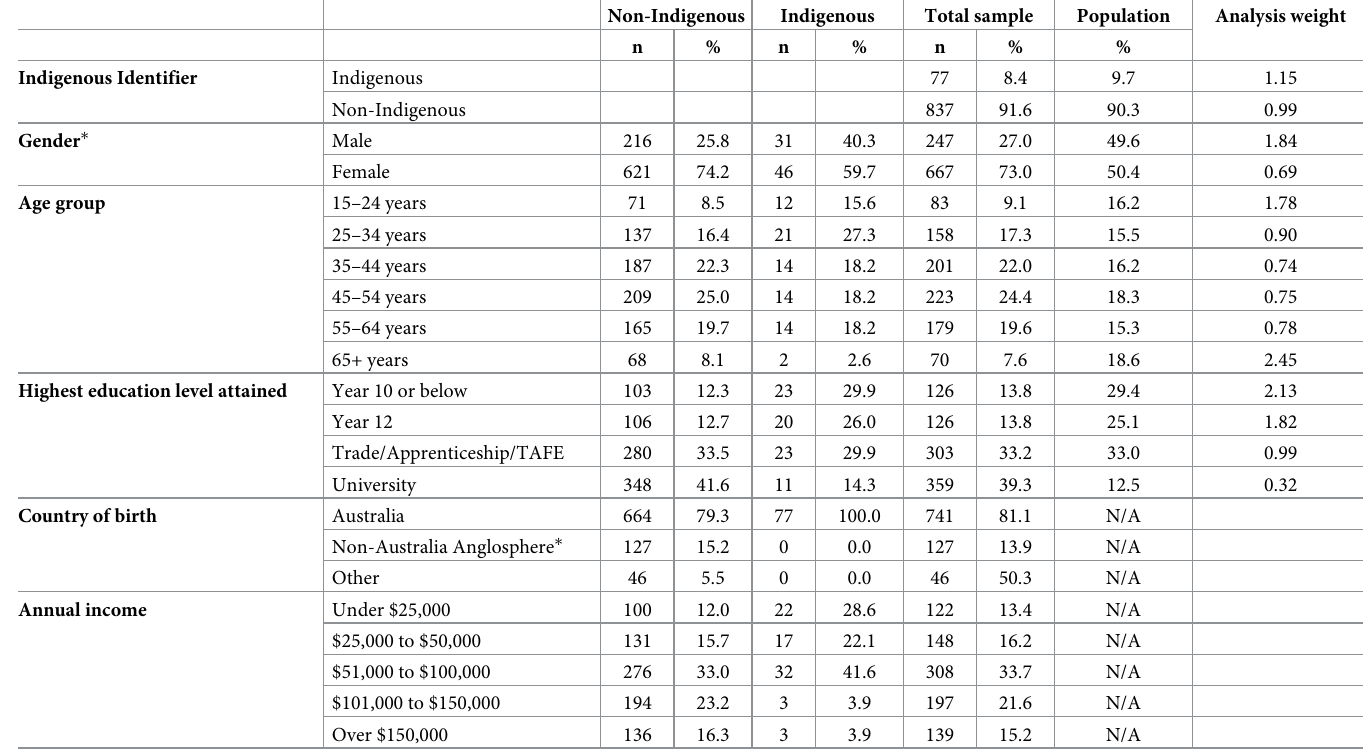
Table 1. Characteristics of survey respondents (N = 914) in comparison with greater geraldton population, by indigenous